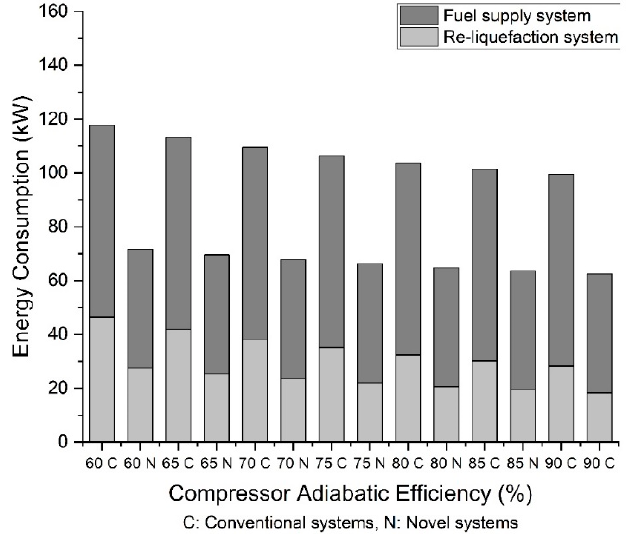
Figure 8. Energy consumption for conventional and novel re-liquefaction and fuel supply systems with compressor adiabatic efficiency.